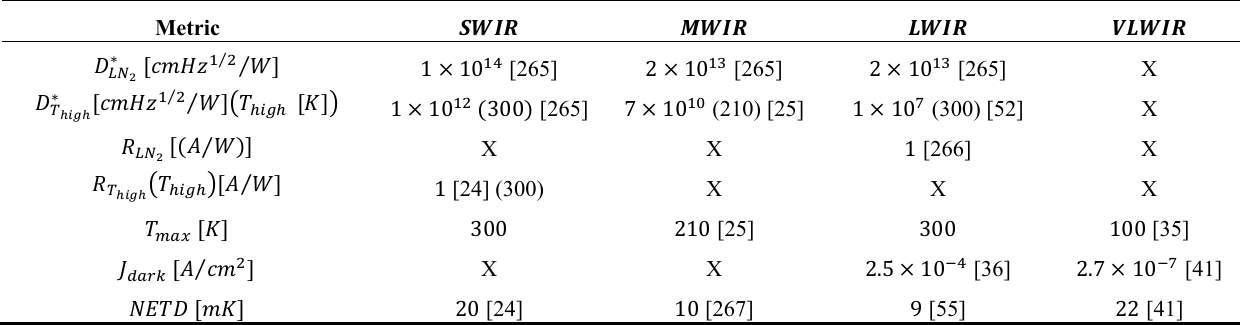
Table 1. Highest reported performance metrics for HgCdTe IRPDs across different wavelength regimes.